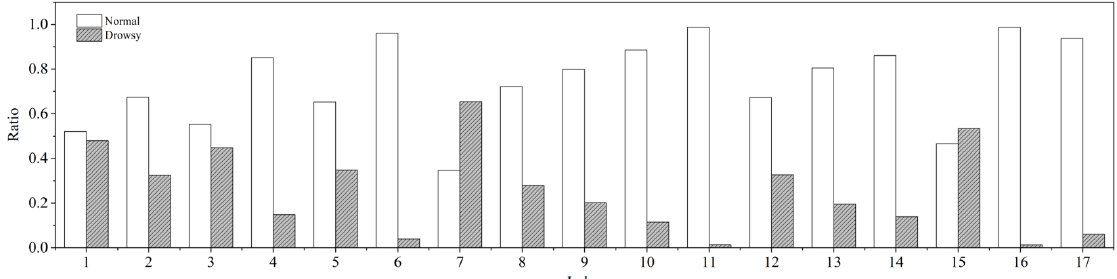
Figure 1. Ratio of normal driving and drowsy driving by